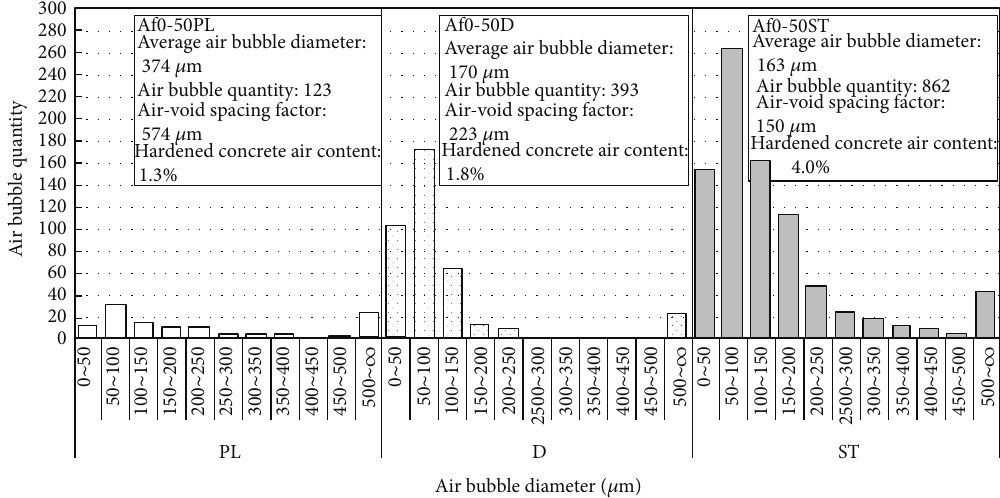
Figure 13: Relationship between air bubble diameters and quantity of air bubbles.